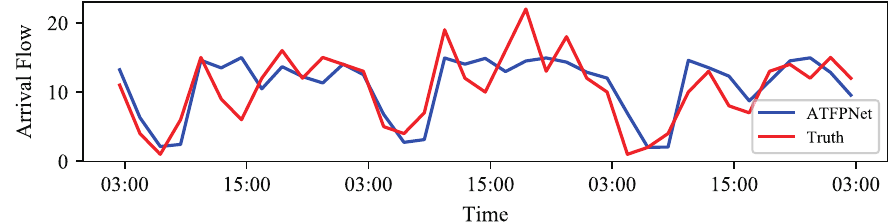
Figure 8. The prediction results of the 90-min horizon.